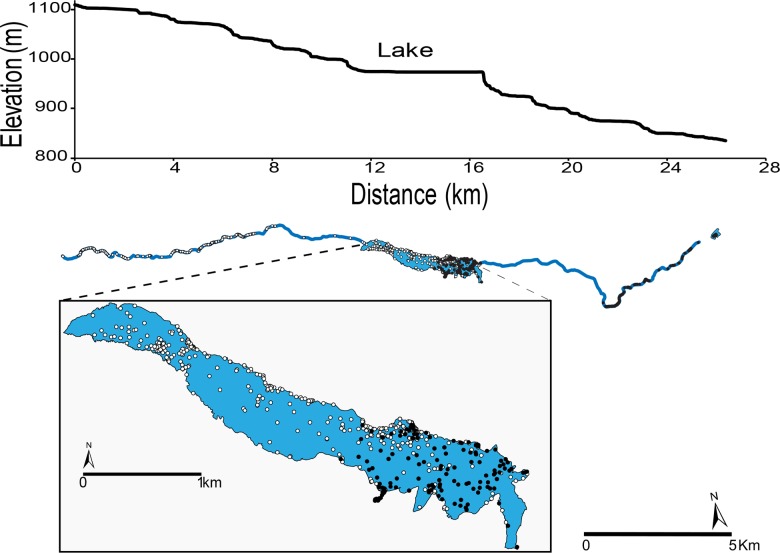
Elevation gradient (above) and map (below) of study area, Sangro river and Barrea Lake (in the Abruzzo Lazio and Molise National Park and its buffer zone, Central Italy) with locations (fixes) of 23 Myotis daubentonii detected by radio tracking.Note the overlap of foraging areas used by males (open circles = upstream males, closed circles = downstream males) from the two altitudinal zones in the lake area.